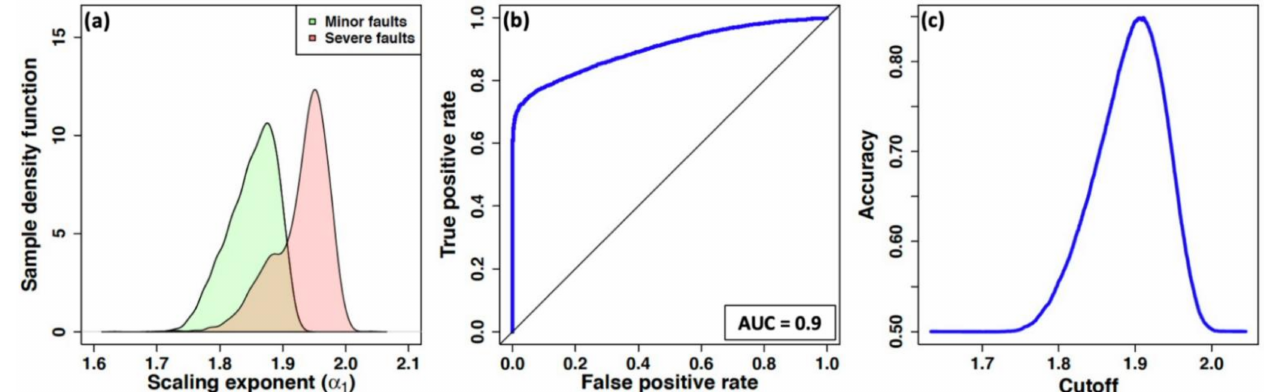
Figure 8. ( a ) Scaling exponent ( α 1 ) distributions of bearing vibration signals (1000 samples each) collected from faulted bearings. ( b ) ROC curve for the proposed method. ( c ) Accuracy vs. cutoff plot.